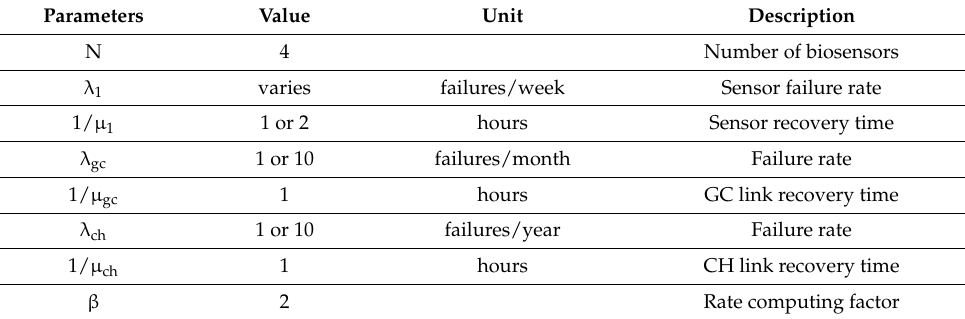
Table 1. Typical parameter configuration for numerical evaluation.